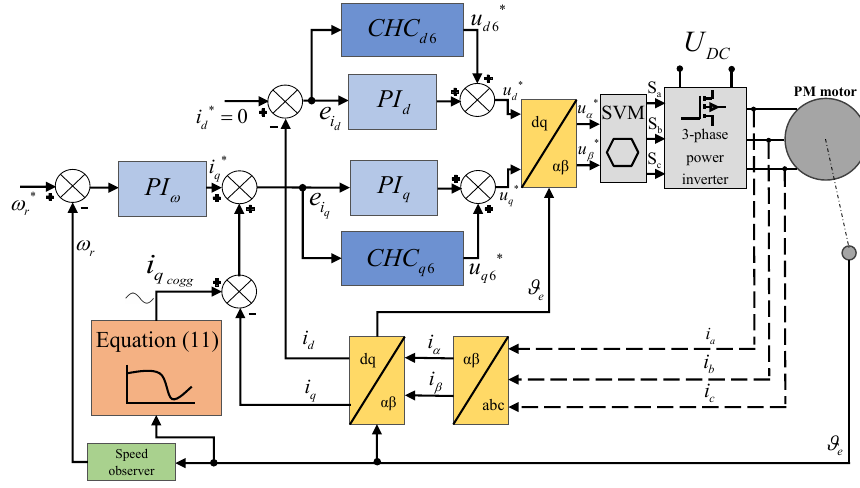
Figure 12. Proposed modification of